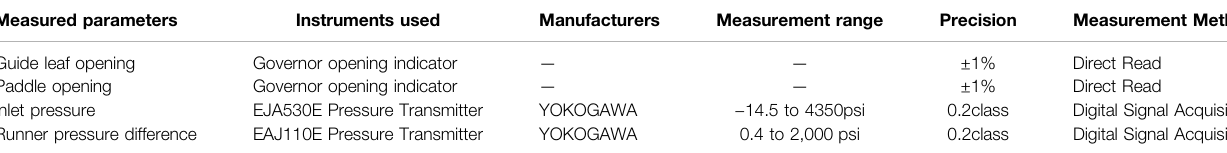
TABLE 2 | Instruments required for the